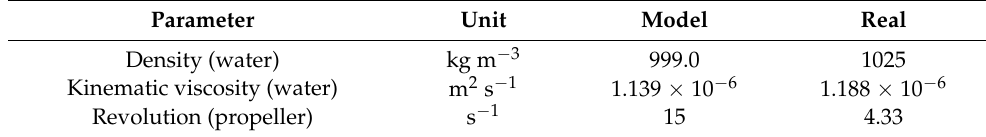
Table 4. Mesh independency study for vp1304